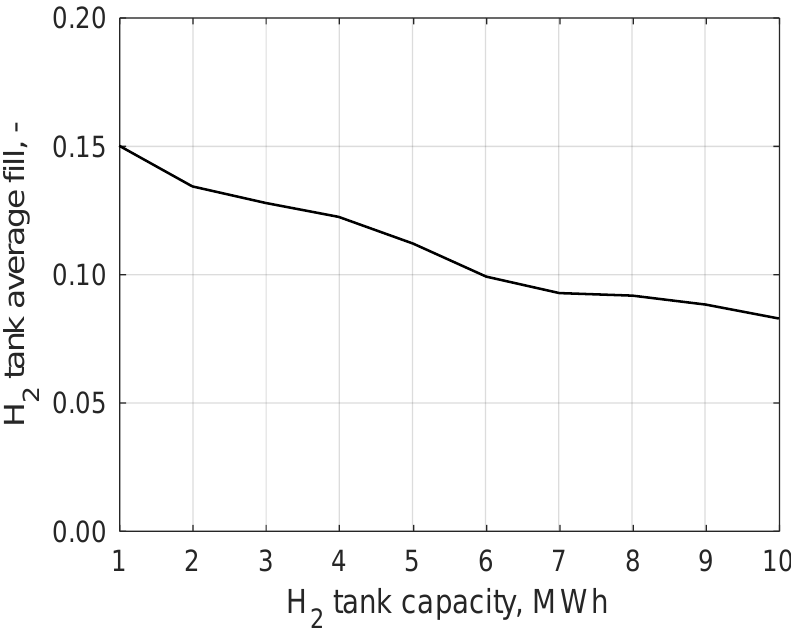
Figure 5. Graph showing the average fill of the hydrogen buffer over an annual operation.